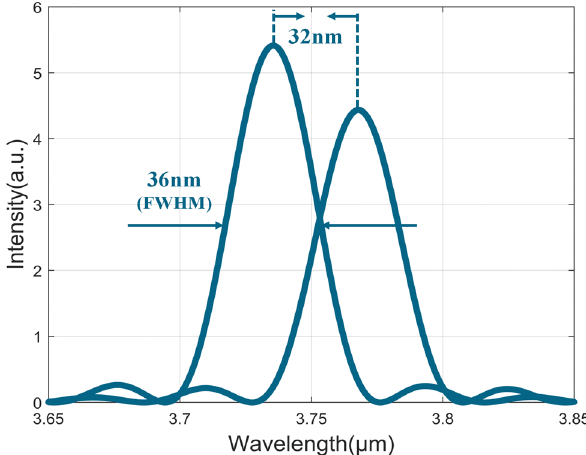
Figure 4. Simulated double-peaked idler beam.